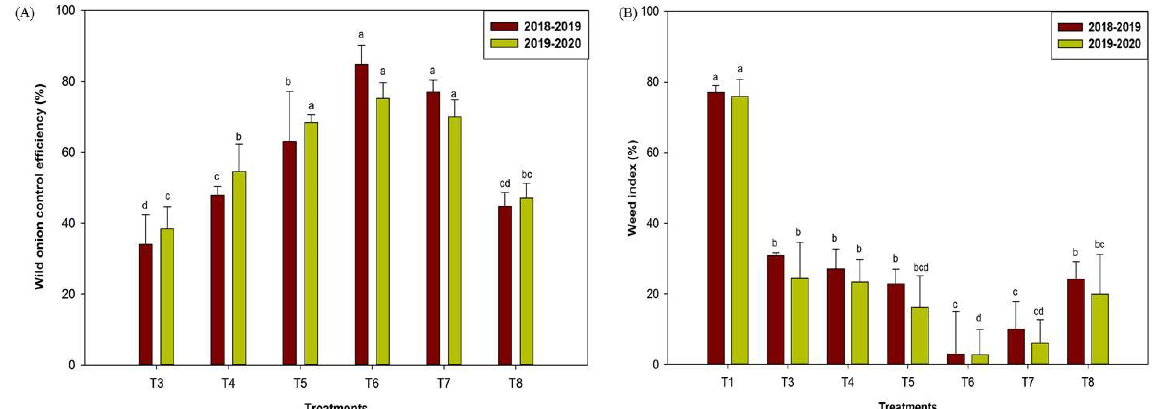
Figure 3. Wild onion ( Asphodelus tenuifolius ) control efficiency ( A ) and weed index ( B ) of different herbicidal weed management treatments in cumin. Where, T 1 = weedy check; T 3 = pendimethalin 38.7 CS @ 750 g/ha–PE; T 4 = oxyfluorfen @ 200 g/ha–PE; T 5 = pendimethalin 38.7 CS 500 g/ha + oxyfluorfen 150 g/ha @–PE; T 6 = oxyfluorfen @ 200 g/ha 8 DAS–early POE; T 7 = pendimethalin 38.7 CS 500 g/ha + oxyfluorfen @ 150 g/ha 8 DAS–early POE; T 8 = oxydiargyl @ 50 g/ha 20 DAS–POE. Error bars show SD; Fisher LSD method at 95% confidence ( p ≤ 0.05) was used to group information between the mean values of acquired data. Different letters point out significant differences among the treatments in a particular year.